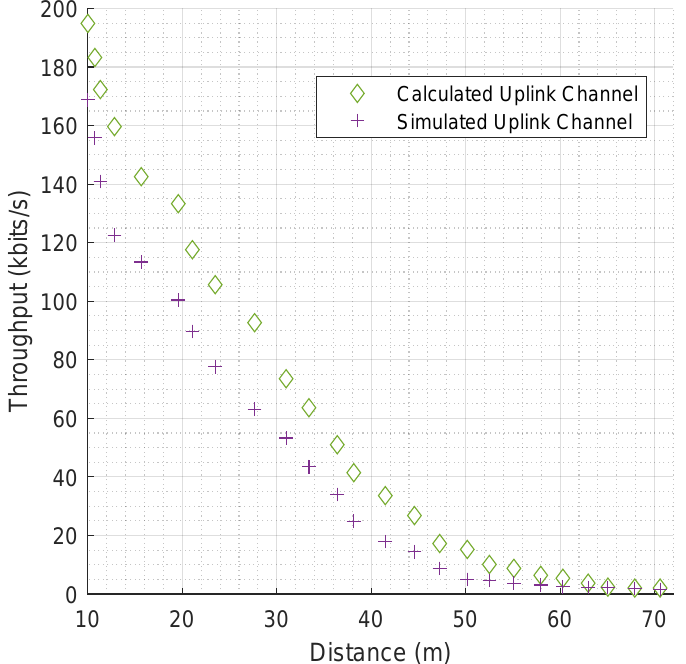
Figure 9. The evaluation of throughput (kbits/s) for both simulated and calculated NB-IoT uplink channels based on distances from the transceiver.